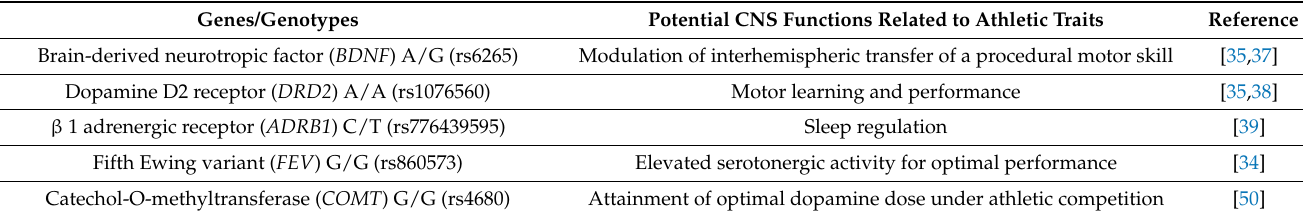
Elevated serotonergic activity for optimal